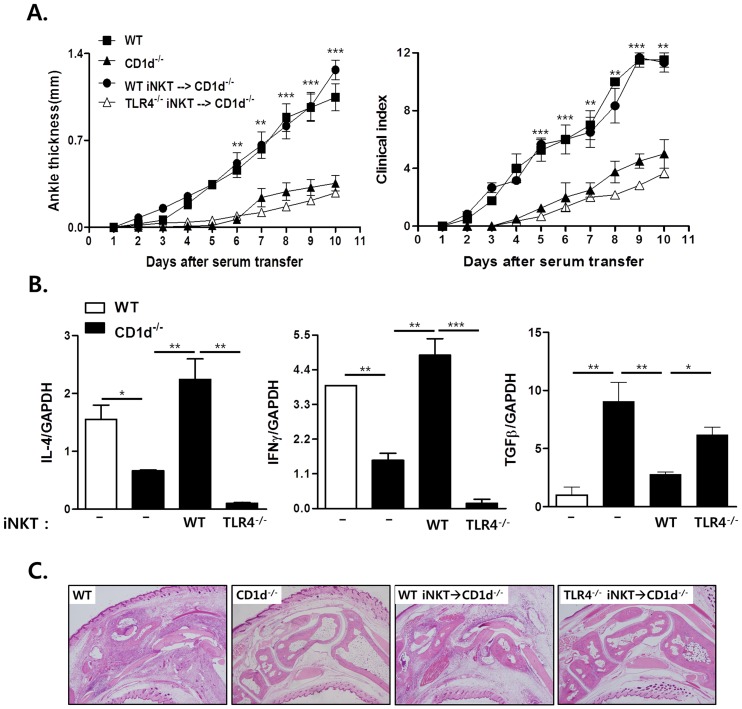
TLR4 in iNKT cells plays a crucial role in promoting antibody-induced joint inflammation.(A) Sorted WT or TLR4-deficient iNKT cells (3×105cells mouse−1) were adoptively transferred into CD1d−/− mice one day before K/BxN serum transfer (n = 3 per group). Clinical scores and ankle thickness were then monitored (*p<0.05 and **p<0.01, ***p<0.001). (B) The amounts of IL-4, IFN-γ and TGF-β1 were measured relative to GAPDH by real-time PCR in the joint tissues of B6, CD1d−/−, and CD1d−/− mice administered sorted WT or TLR4-deficient iNKT cells 10 days after K/BxN serum transfer. (C) Histological examination of the joints was performed 7 days after K/BxN serum transfer (×100). Data are representative of three independent experiments. (n = 4 in each group; *p<0.05, **p<0.01, ***p<0.001).